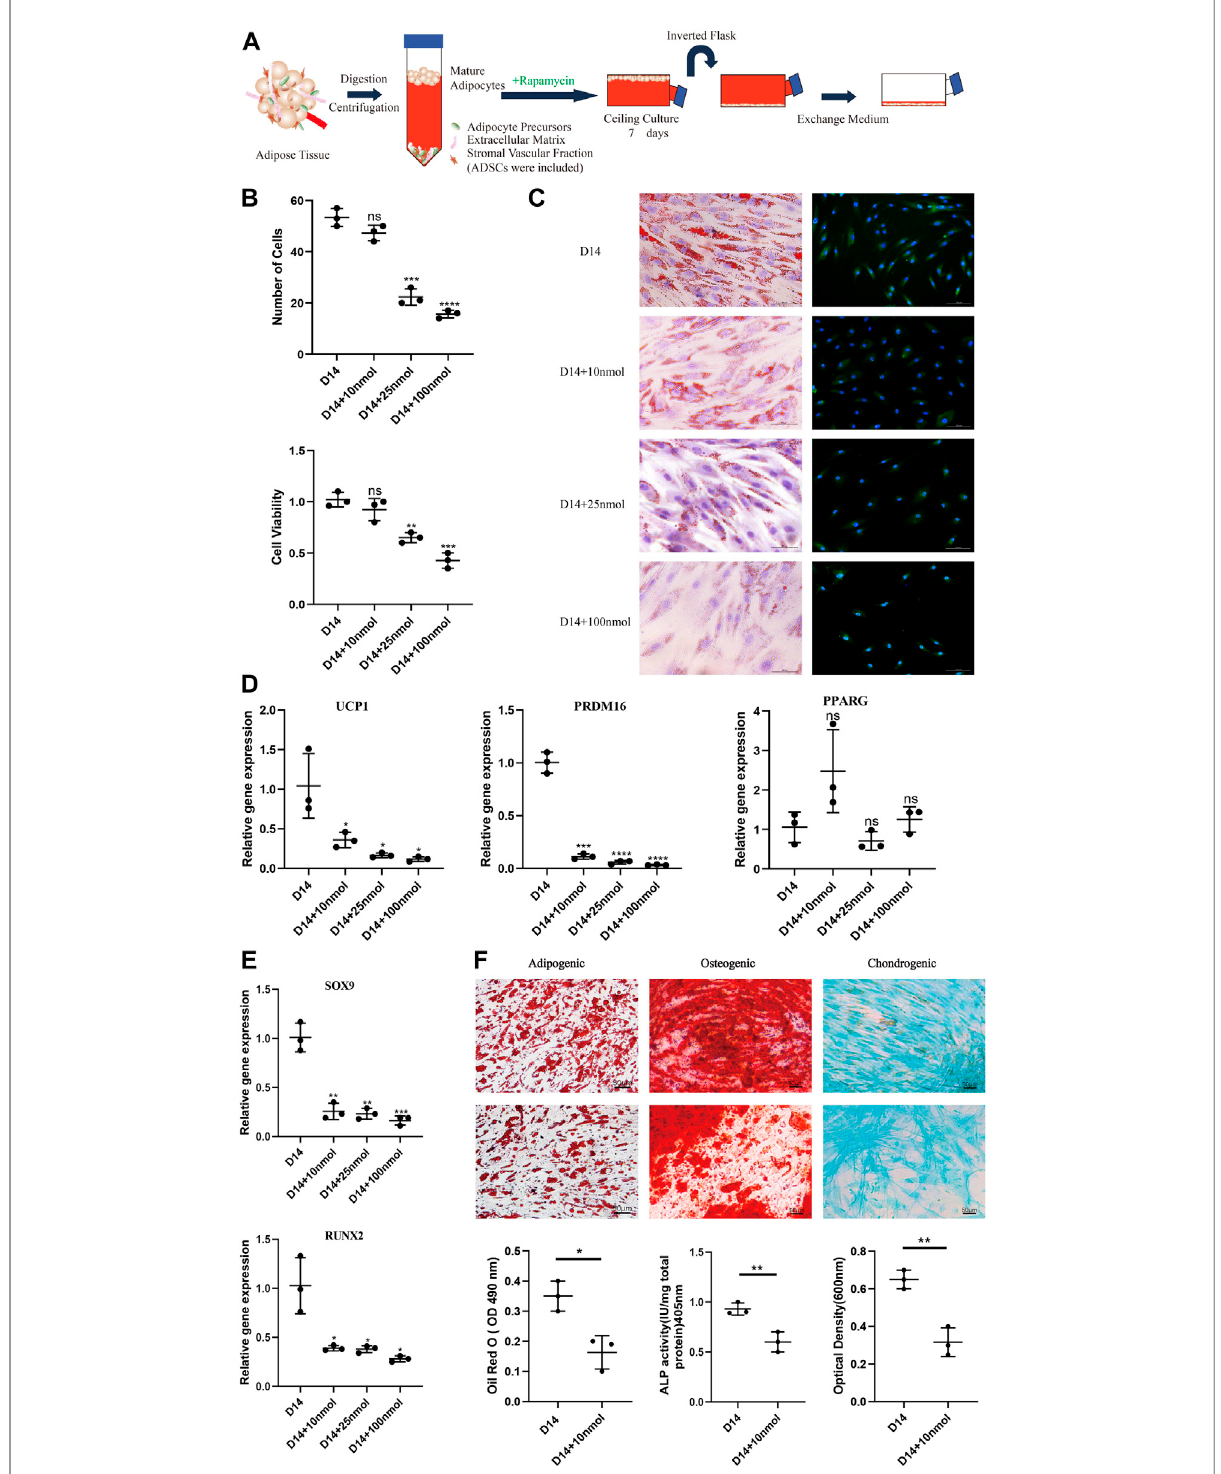
FIGURE 2 Effect of rapamycin on the dedifferentiation capacity of mature white adipocytes. (A) Model depicting the use of rapamycin to culture mature adipocytes. (B) MTT assay results con fi rmed that cell viability of dedifferentiated adipocyte (DA)-intermediate cells was inhibited by rapamycin, and theeffectwasconcentration-dependent. (C) IntracellularlipiddropletswerestainedwithOilRedOandvisualizedbylightmicroscopy.Fluorescence microscopy visualizedUCP1expression stainedwithAlexaFluor488(green)and nuclei stainedwithDAPI(blue),incells treatedwith10,25,and